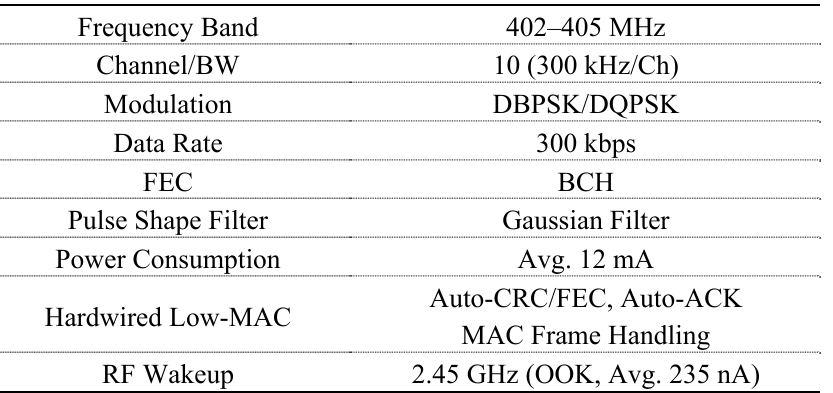
Table 1. PHY characteristics of the hardware